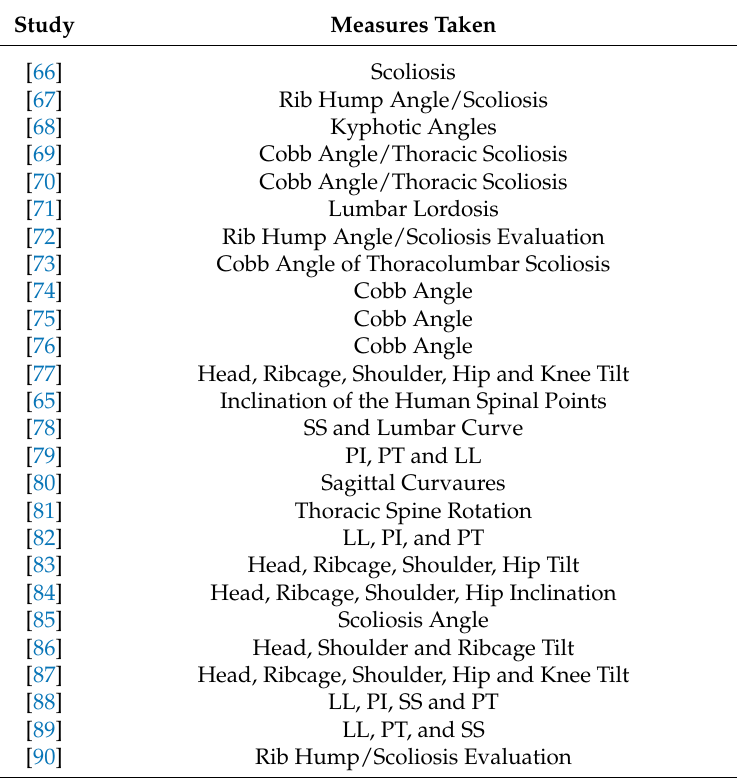
Table 9. Measured segments by the identified mobile